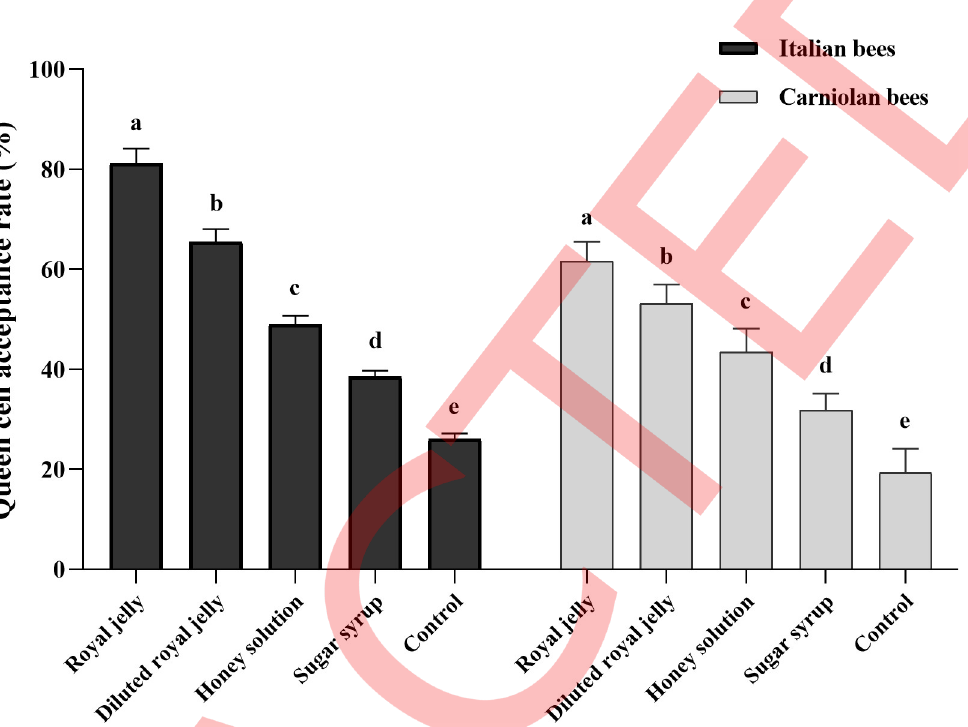
Fig 3. The effect of various priming media or coating material on queen cell acceptance rate (shows as mean ± SE) between Italian and Carniolan colonies. “ a, b, c, d, e ” different letter represents significant mean differences (Student’s t - test, p < 0.05).